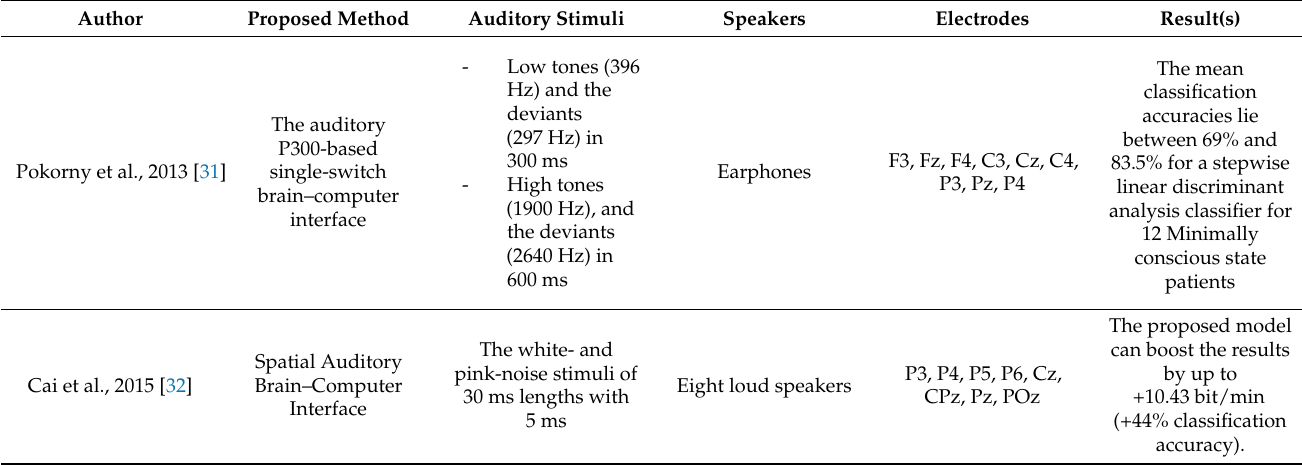
Table 1. Research studies on the auditory stimulus for event related potential (ERP)-based brain– computer interface